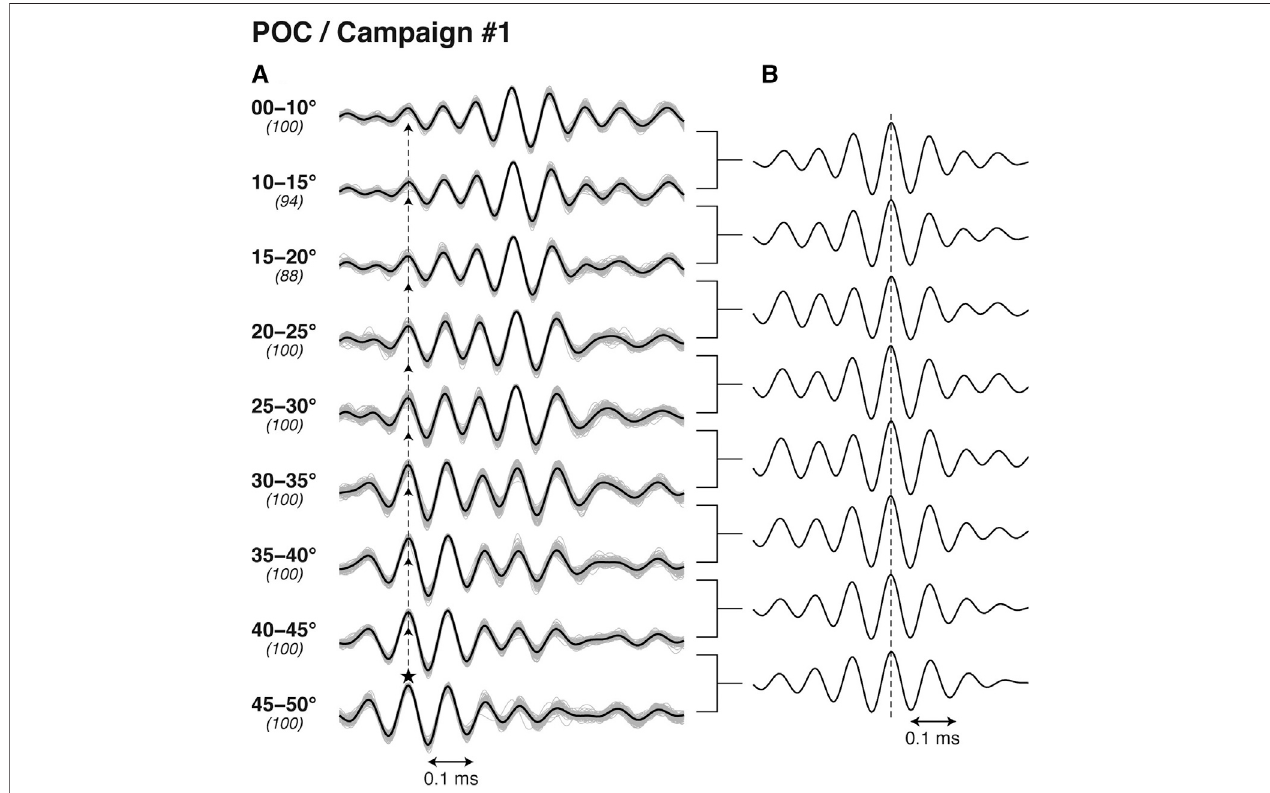
FIGURE 4 | POC templates created from the data of the same campaign as shown in Figures 2 and 3 . (A) Templates for each zone of incident angle. A vertical dashed line indicates the position of the main peak. (B) Cross-correlation between the adjacent templates. A vertical dashed line indicates position of the zero lag.